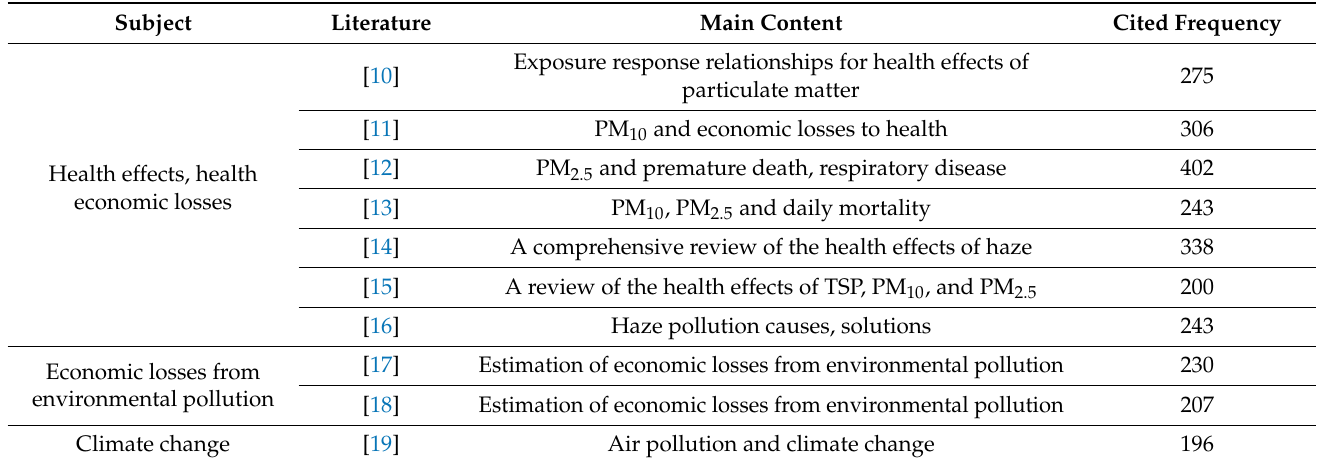
Table 1. Highly cited Chinese literature.